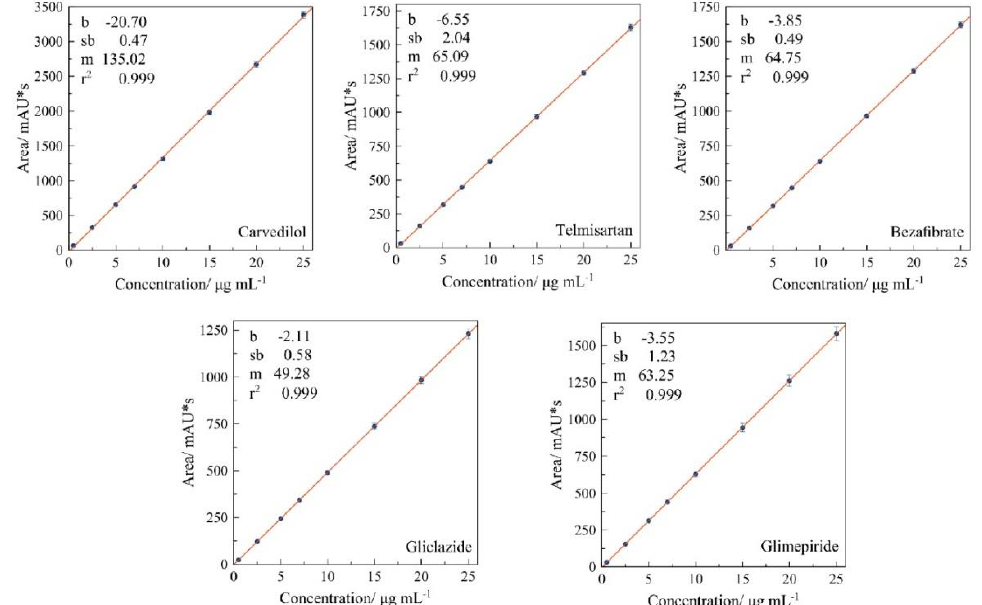
Figure 4. Calibration curves for the active pharmaceutical ingredients showing the linearity of the method. Error bars represent standard deviation from n = 5. Value of intercept ( b ), standard deviation of intercept ( σ b ), slope ( m ), and correlation coefficient (R 2 ) were obtained from linear regression ( y = mx + b